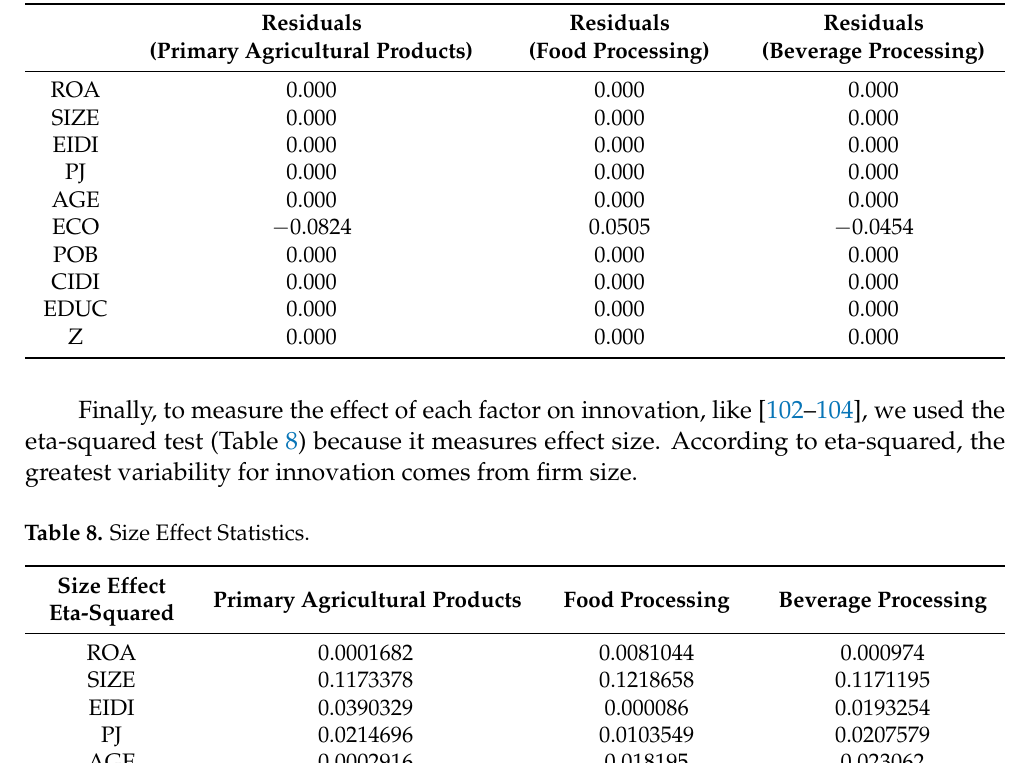
Table 7. Endogeneity test: correlation between the residuals series and the exogenous variables.